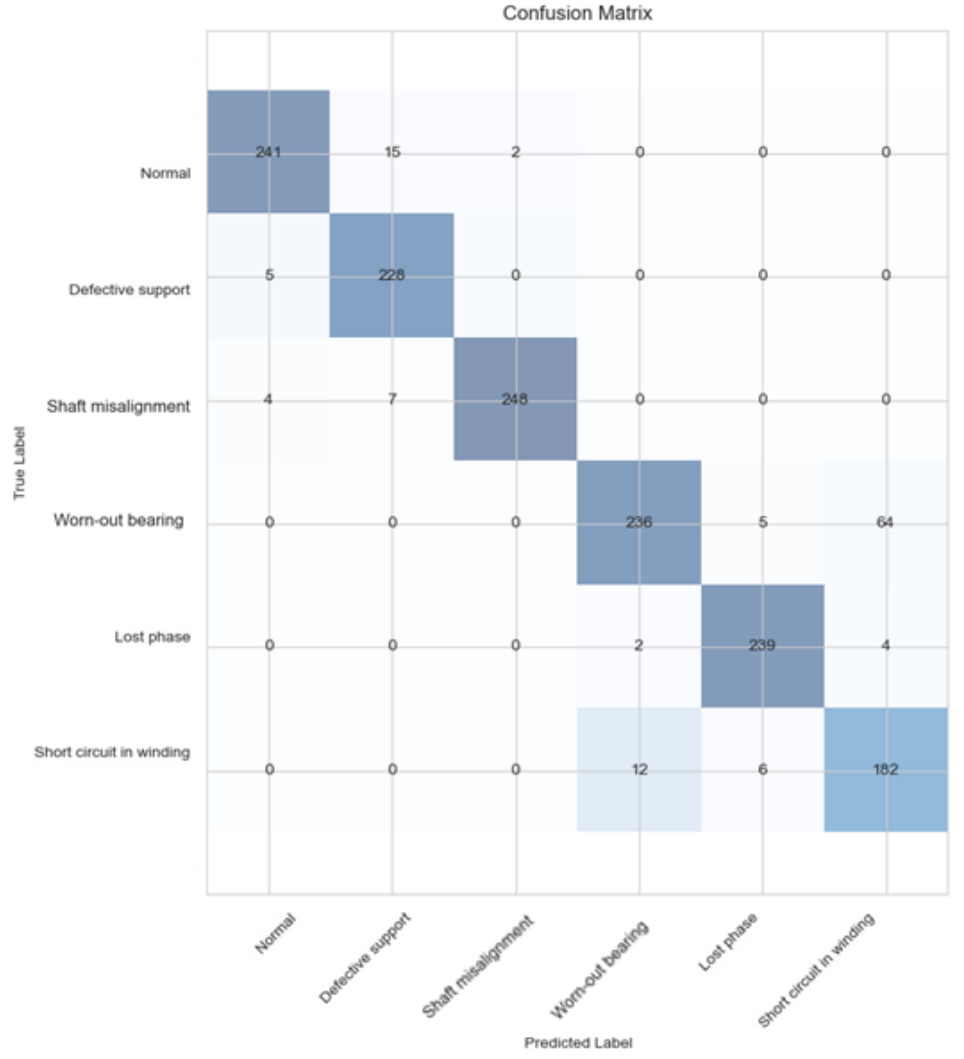
Figure 14. Results for PCA classification